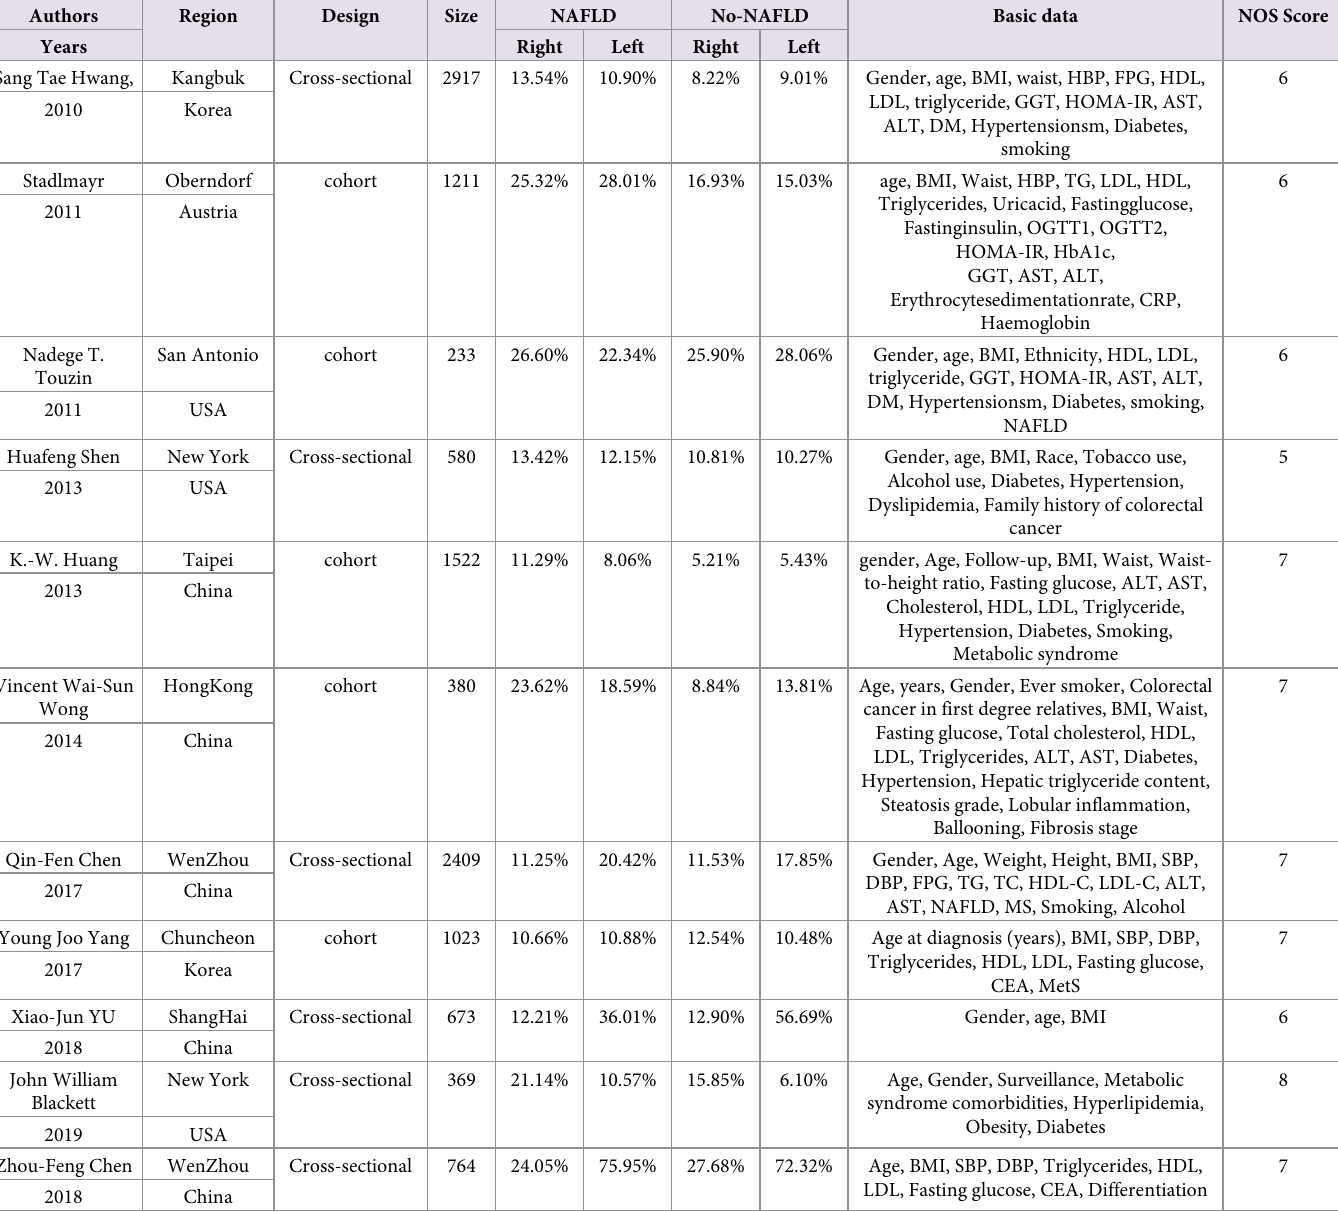
Table 1. Characteristics of studies in